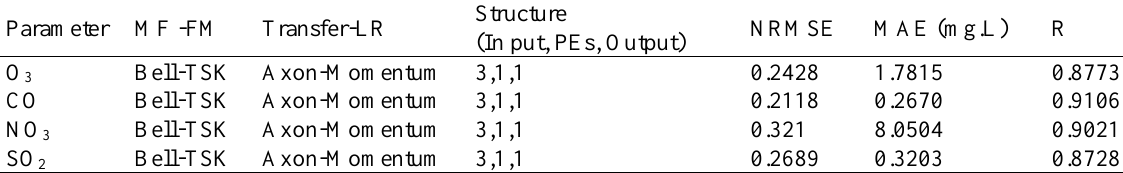
Fig. 3. Desired network output and actual data Table 4. Structures and results of CANFIS